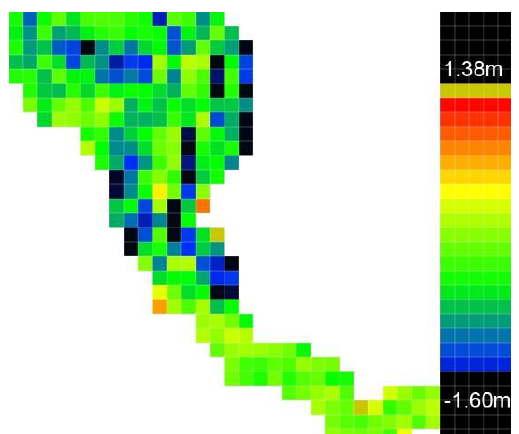
Fig. 12: Color coded height differences AW3D30 against LiDAR